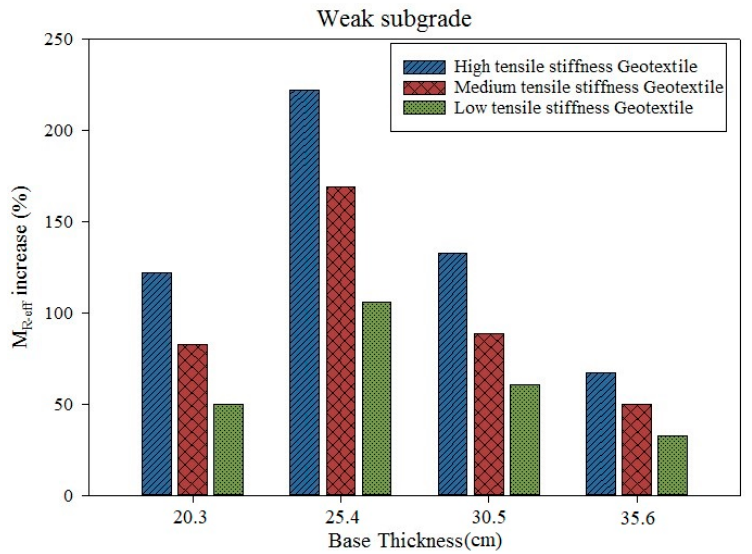
Figure 14. Changes in M R-eff increase of pavement reinforced with a geotextile on weak subgrade soil for different geosynthetic stiffnesses.